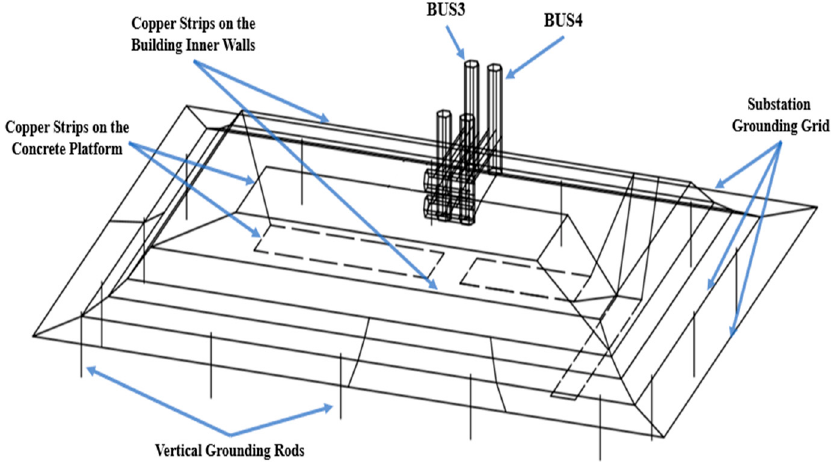
Figure 6. CAD representation of analysis stage 4: GIS model with two bus sections’ modules.